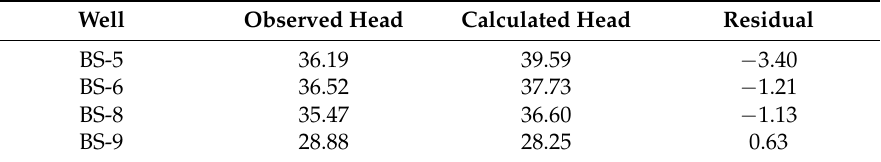
Table 13. The results of the steady-state model’s calibration (unit: a m.s.l., m).